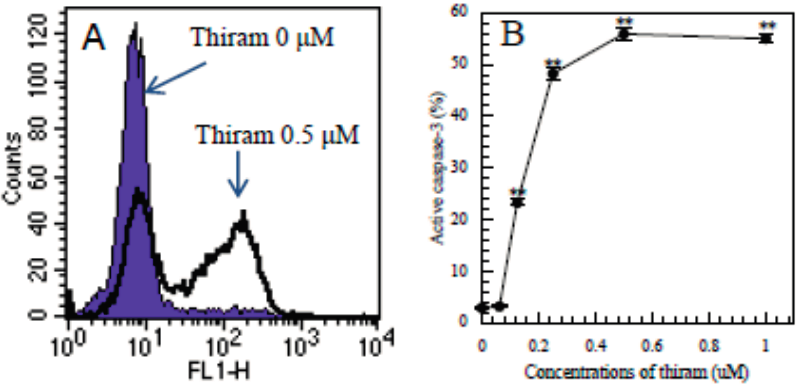
Figure 5. Thiram induced an increase in active caspase-3-positive Jurkat T cells. ( A ): the shaded histogram shows the control cells (thiram at 0 µM) and the open